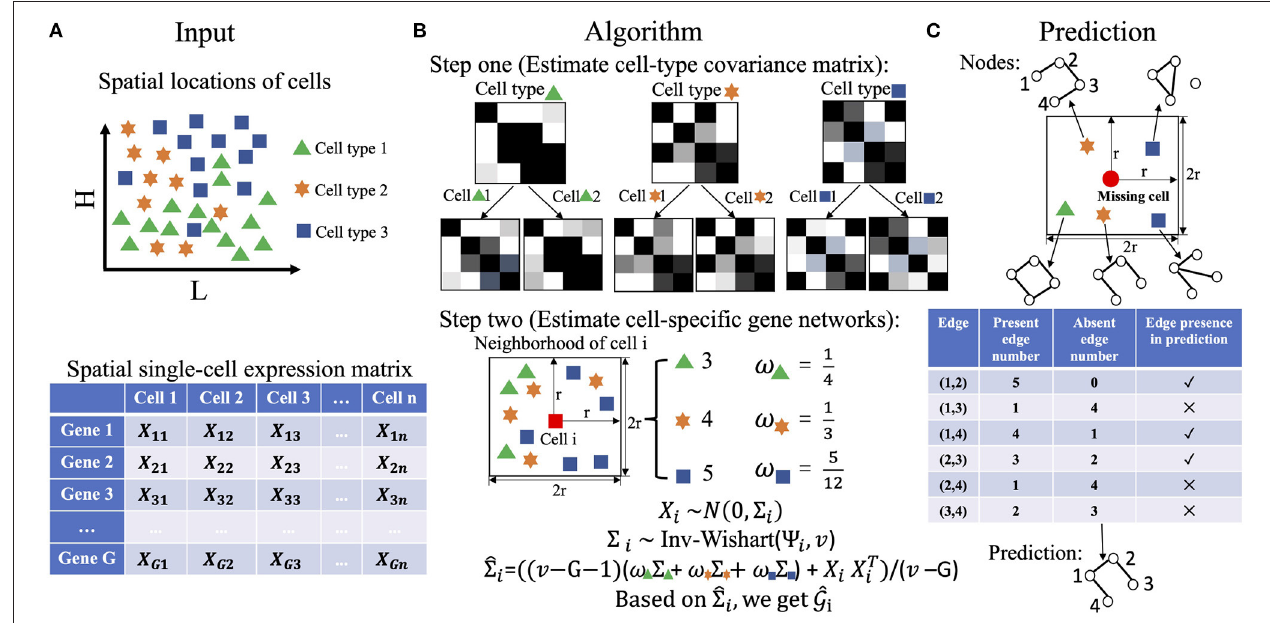
FIGURE 1 | An illustration of the two-step algorithm. (A) The input of the algorithm, including spatial coordinates of cells, the gene-cell expression matrix, and cell class information. Different shapes and colors represent different types of cells. (B) The two steps in the proposed algorithm. We first estimate cell-type covariance matrices, and then we use those estimates to refine cell-specific gene co-expression networks. (C) Gene co-expression network prediction based on the estimates from (B)